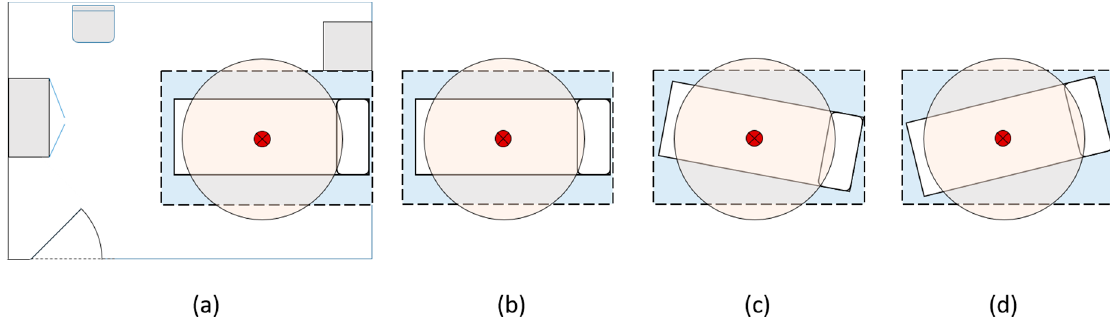
Figure 2. Bed positions and layout of room showing location of the ceiling-mounted device as the small dark red point, the FLIR-sensors field of view as the square blue area, and the ultrasonic sensor area as the semi-transparent circular area: ( a ) Room layout; ( b ) Bed position 1; ( c ) Bed position 2; ( d ) Bed position 3.